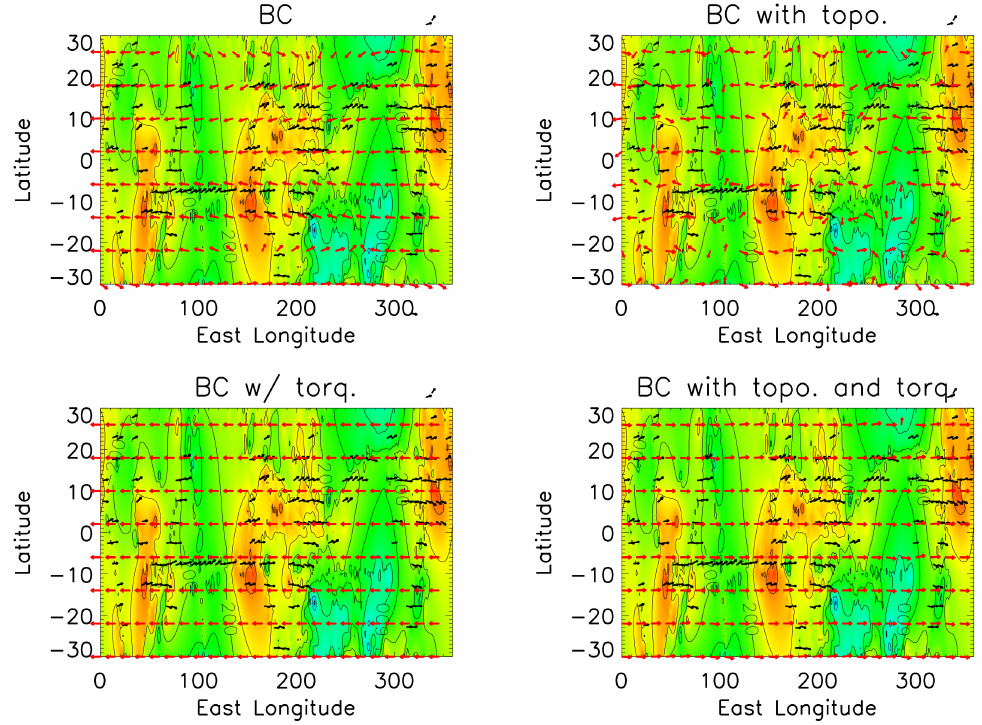
Figure 9. RDD vectors for each simulation with wind threshold of 0 m / s overlaying the topographic map with dune orientation vectors from Figure